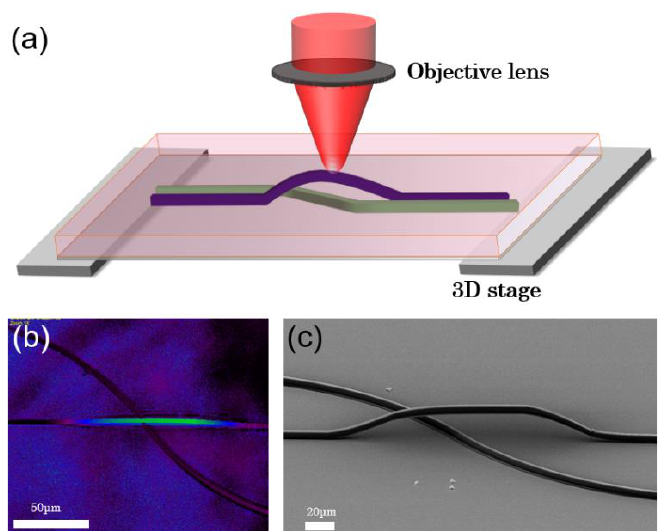
Figure 1. ( a ) The laser processing of photonic jumper wire. ( b , c ) Confocal micrograph SEM image of the jumper wire.